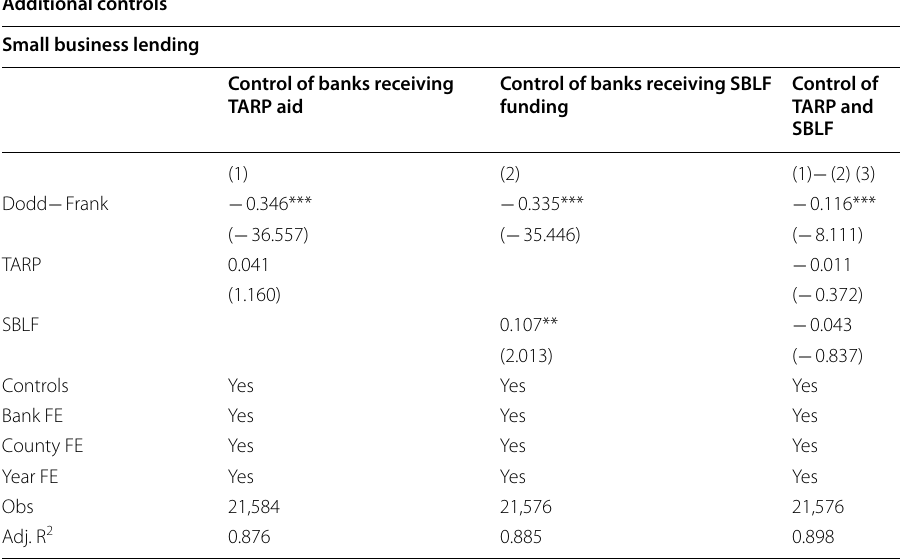
Table 11 Tests for successive